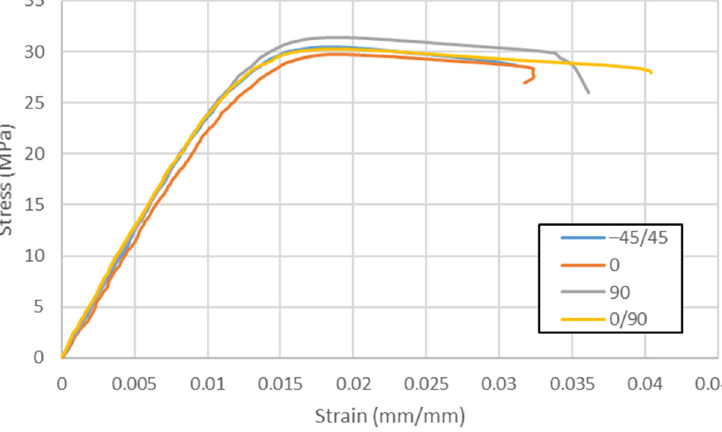
Figure 7. Representative Tensile Stress-Strain Curves.